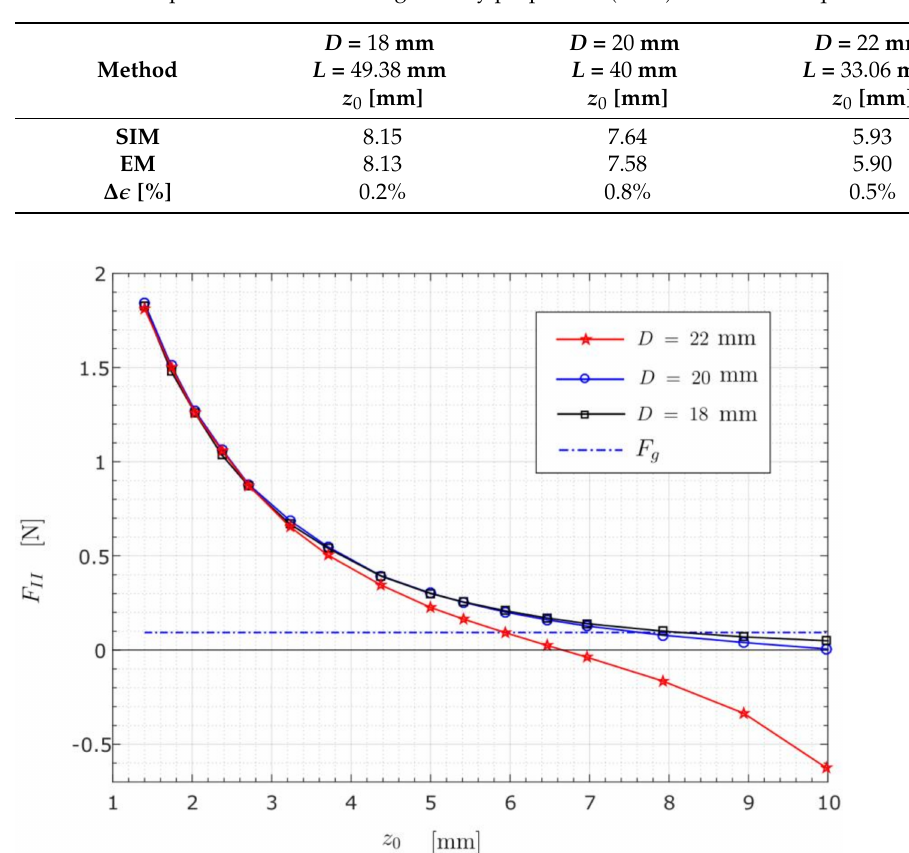
Table 7. The impact of the container’s geometry proportion ( D / L ) on the PM’s equilibrium height.